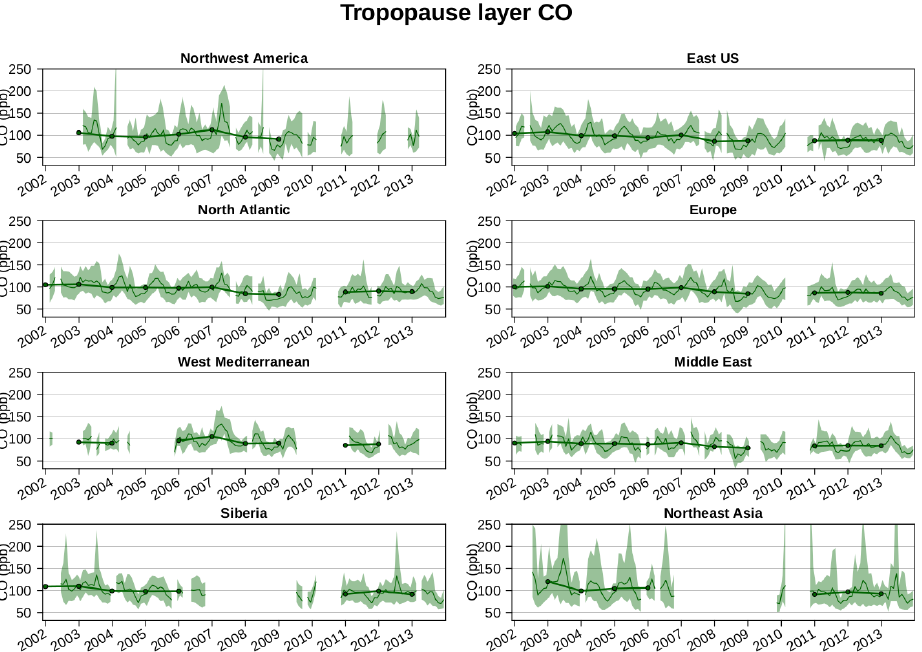
Figure B5. CO monthly mean values in the TPL (thin curve). The interval from 5th and 95th percentiles is filled in green. The yearly mean values are represented by the bold curve and the black points.